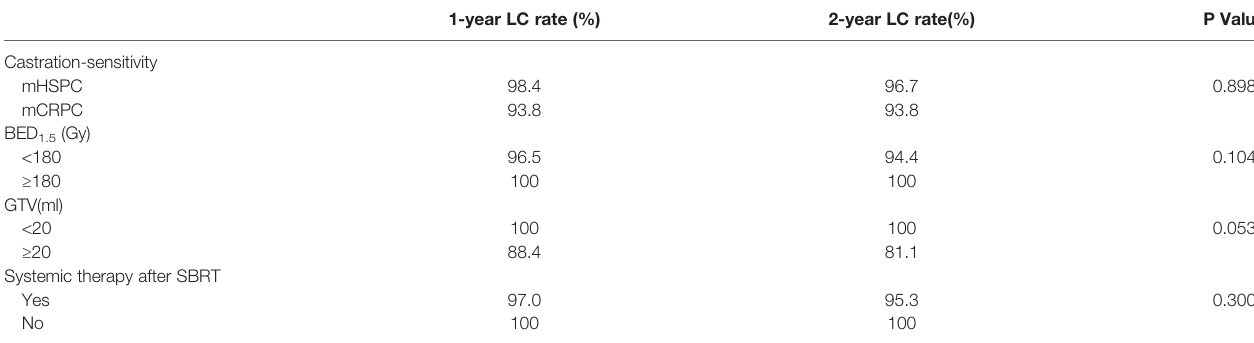
TABLE 4 | Univariate analysis for LC